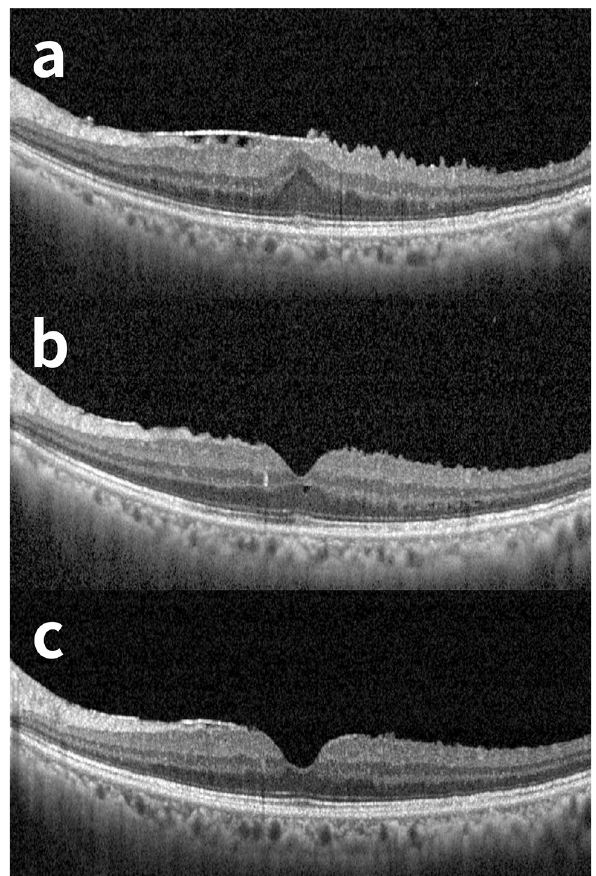
Figure 3. A representative case of non-nasal inner nuclear layer (INL) thickening after epiretinal membrane (ERM) surgery. A 66-year old male with hypertension and hepatitis B visited our clinic for macropsia on his left eye and ERM was revealed on fundus exam. Combined cataract surgery and peeling of ERM were performed under retrobulbar anesthesia. Internal limiting membrane was not peeled off. ( a ) Preoperative optical coherence tomography (OCT) image. At initial, the best corrected visual acuity (BCVA) was 20/32. ( b ) OCT images taken 31 days after the surgery. BCVA has been improved to 20/20. ( c ) At last visit (230 days after the surgery), the structural deformity was not present and BCVA was 20/20 and subjective macropsia has been